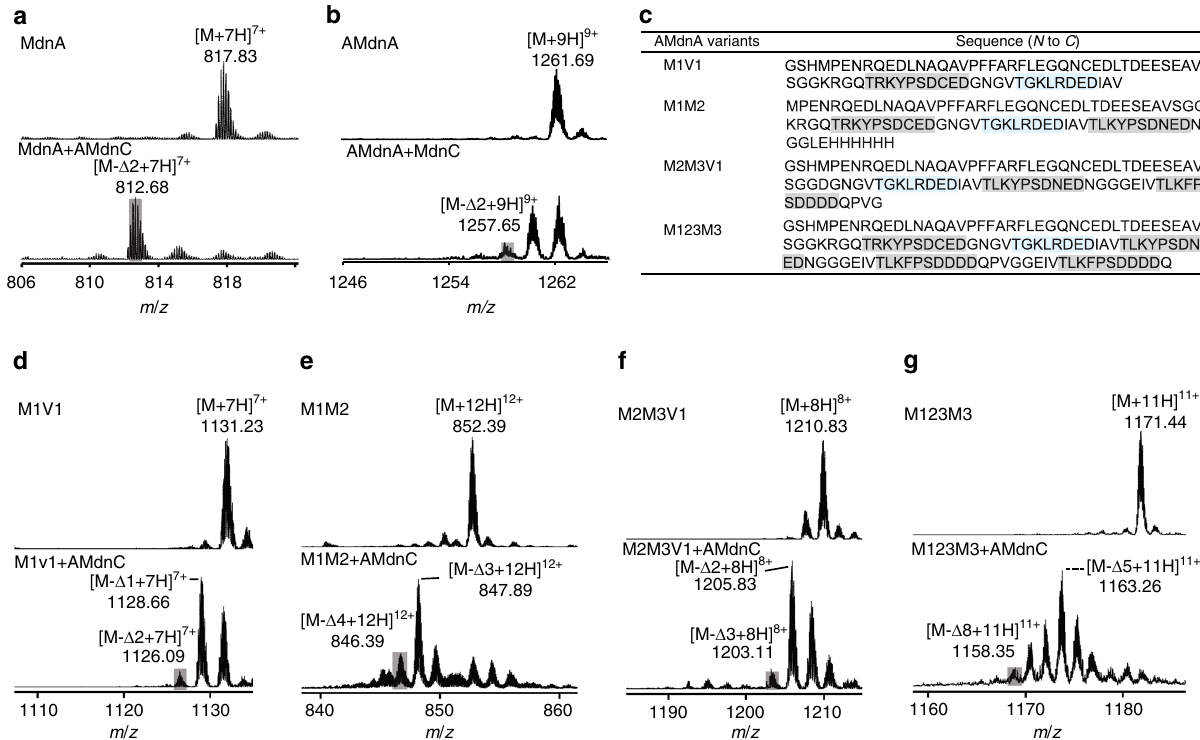
Fig. 7 HR-MS analysis showed the processing of natural and unnatural microviridin precursor peptides. a AMdnC introduced two lactones on MdnA, the precursor peptide of microviridin J. b MdnC installed up to two lactones on AMdnA. c Sequences of select AMdnA variants. The core peptides and quasi core peptide were shaded in gray and light cyan, respectively. d Processed M1V1, e processed M1M2, f processed M2M3V1, and g processed M123M3 in the AMdnC reaction were shown in HR-MS spectra. The most processed intermediates were shaded in gray Table 1 Kinetic parameters of AMdnC in processing AMdnA, MdnA and M1V1